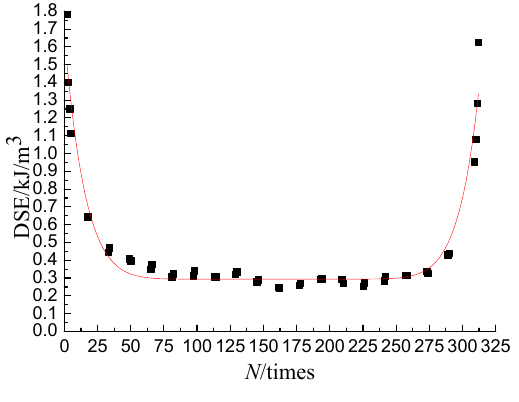
Figure 6. Fitting effect of DSE- N curve. Table 4. Fitting parameters of DSE- N curve.